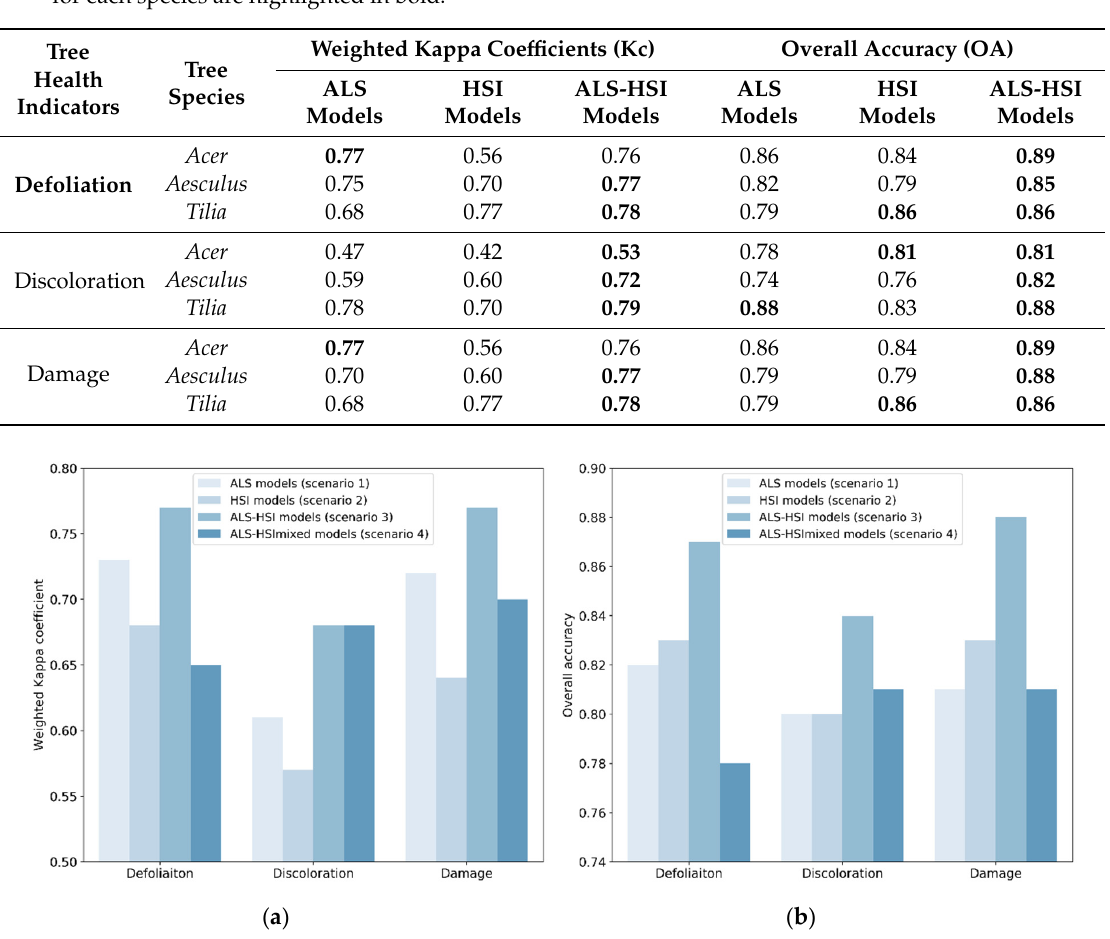
Figure 3. Classification accuracies in the four scenarios: ( a ) Weighted Kappa coefficient (Kc); ( b ) overall accuracy (OA). In scenarios 1–3, the Kc and OA for each tree health indicator were averaged for the three tree species (i.e., Acer spp. , Aesculus spp. and Tilia spp. ).